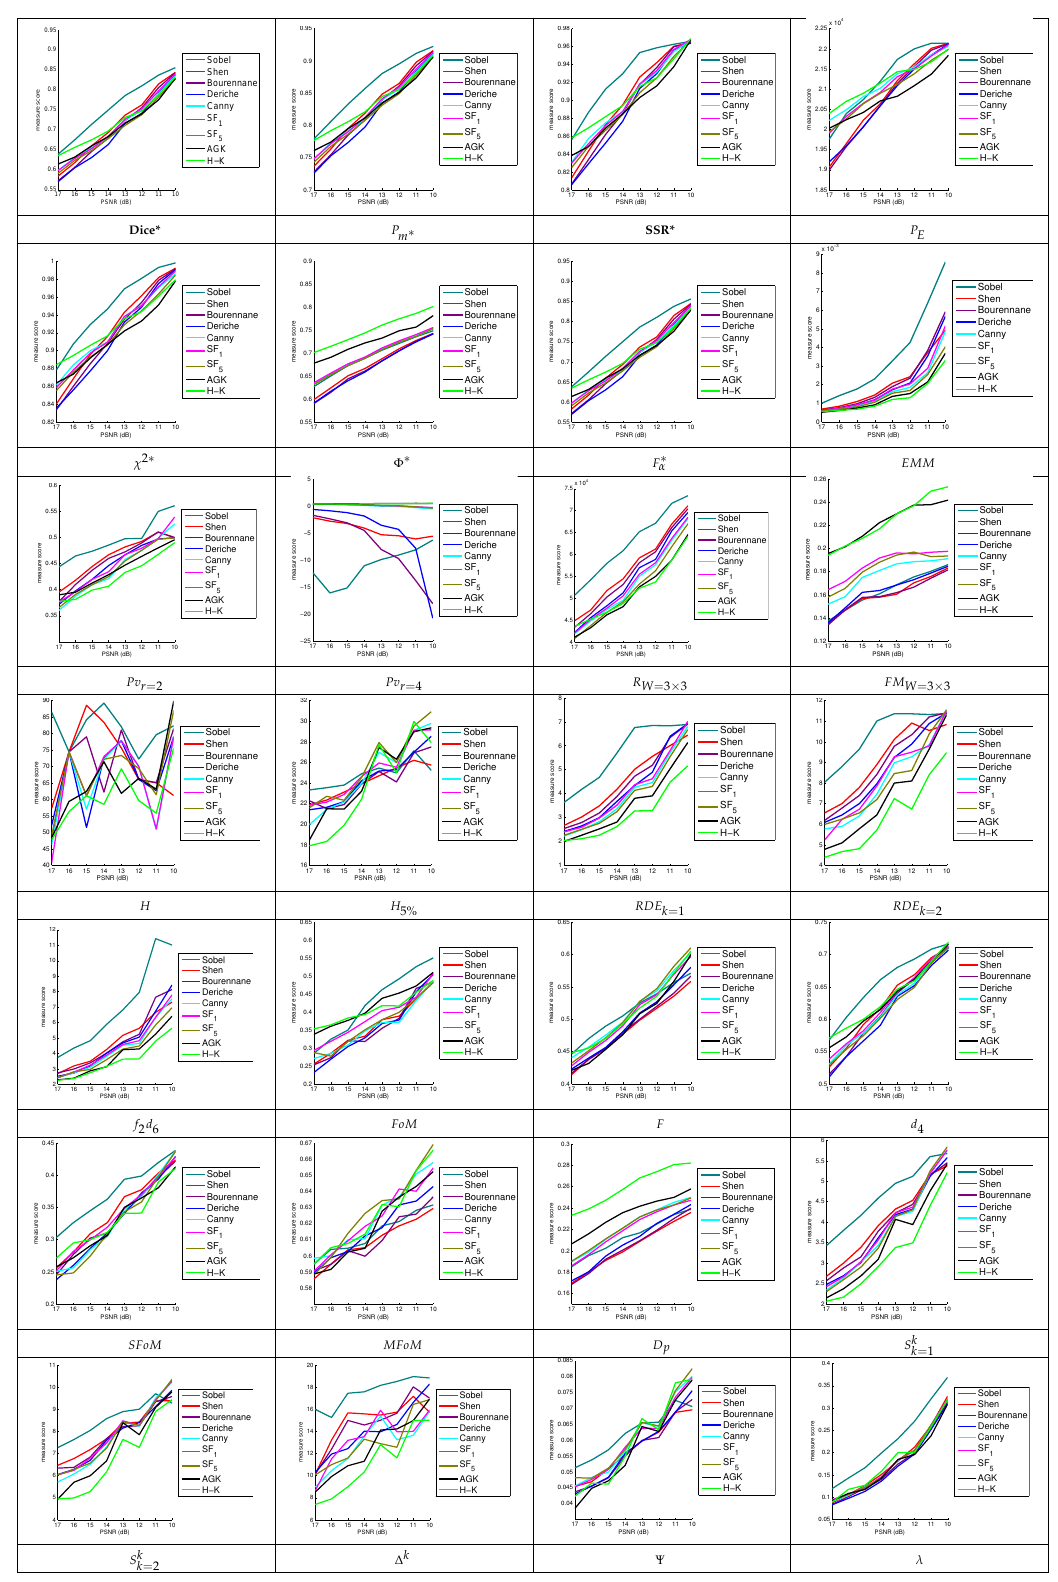
Figure 19. Image parkingmeter: Comparison of edge detection evaluation